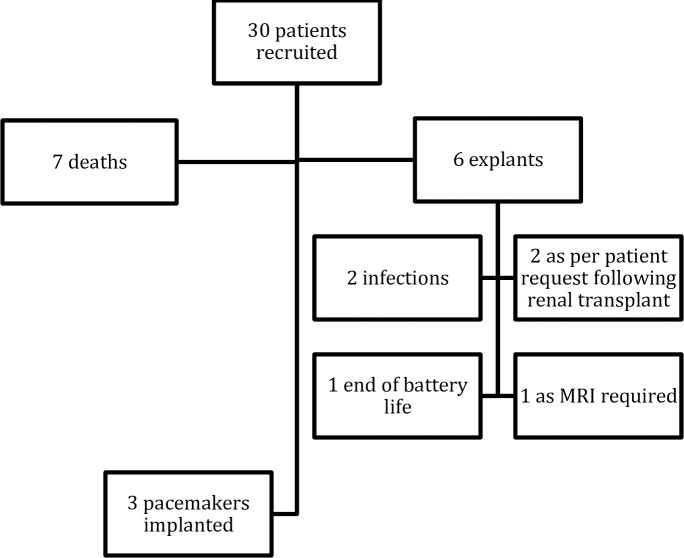
Overview of recruitment and outcomes.